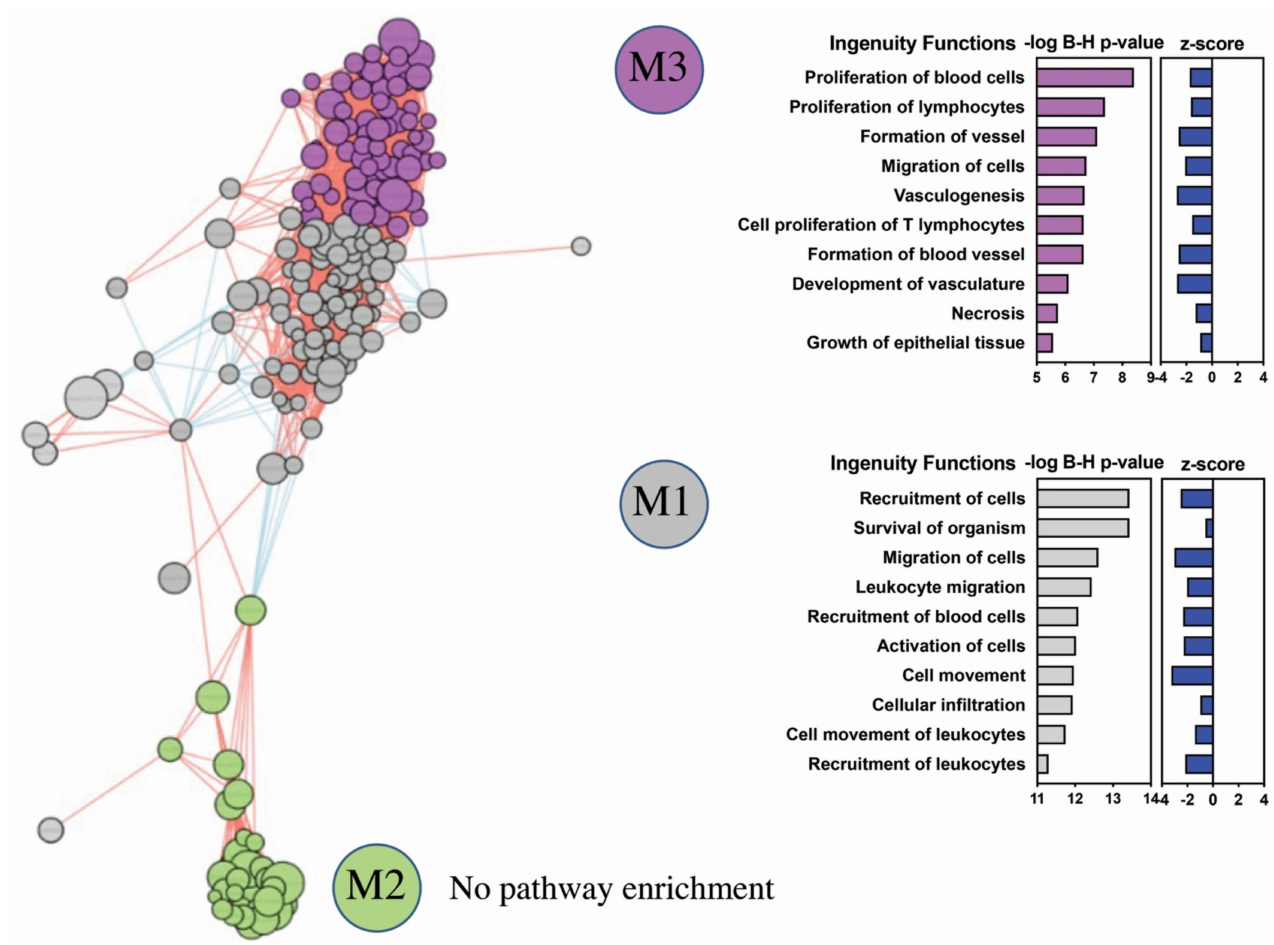
Figure 4. Prediction of the disease relevant pathways represented by differentially expressed genes (DEGs) in peripheral mononuclear cells of patients with idiopathic environmental intolerance (IEI). Three co-expressed gene networks (modules; M1, M2, and M3) were identified from genes that are differentially expressed between IEI patients and controls. The interactions between different inferred co-expressed gene network modules, as well as their corresponding top enriched biological functions and predicted downstream activation states are shown for modules M1 and M3. Biological functions are ranked by − log of Benjamini–Hochberg corrected p values (implemented filter: exclude cancer pathways; include only pathways with ≥ 5 differentially expressed genes). Positive (+) or negative (-) activation scores correspond to downstream activated or inhibited disease/functions, respectively. An activation Z score > |2| is highly predictive of an activated or inhibited disease/function. No enriched biological functions were identified from the genes in module